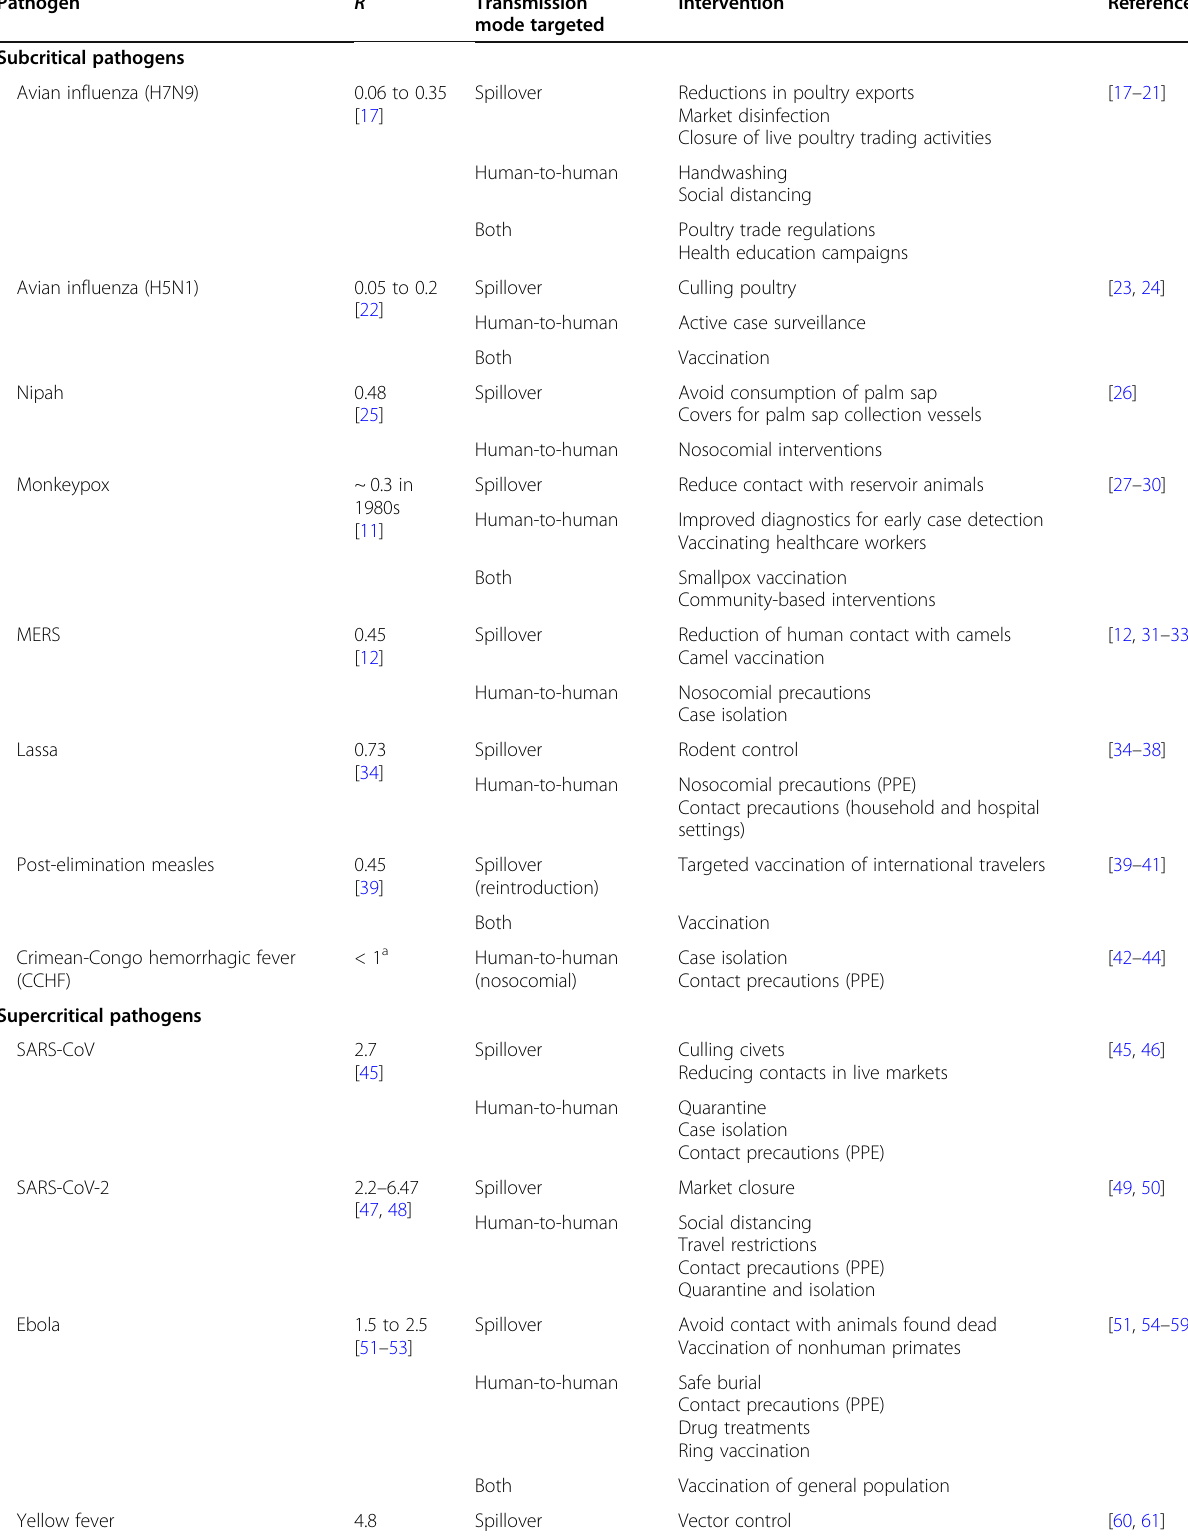
Table 1 A collection of systems which have implemented control measures targeted at spillover animal-to-human transmission, human-to-human transmission, or both and their associated reproductive